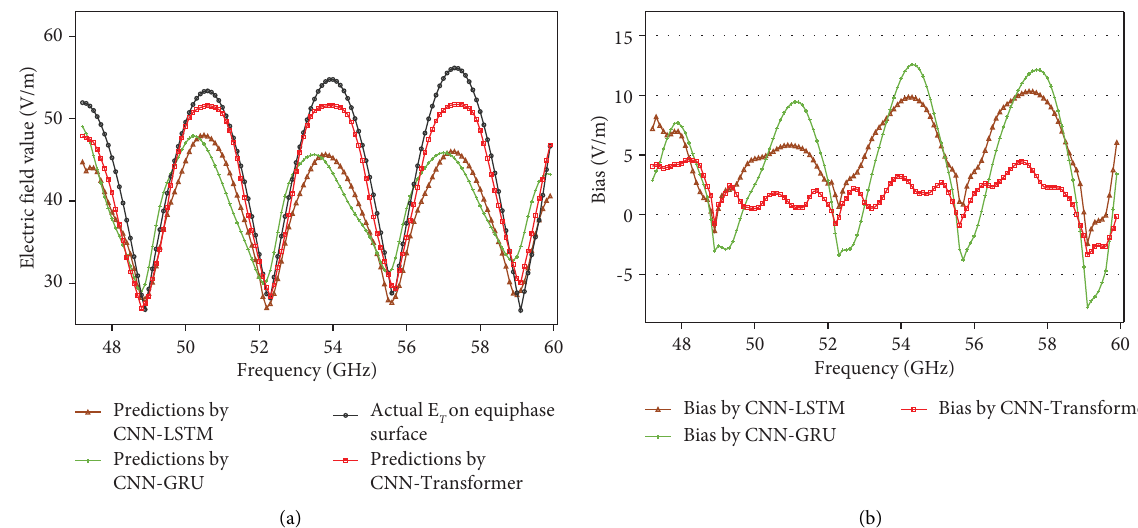
Figure 9: (a) Prediction results of a vertical dipole measured in a FAC: length h � 2 U and 6U, distance d � 3m. (b) Deviation in the predicted results and the actual electric feld on the equiphase